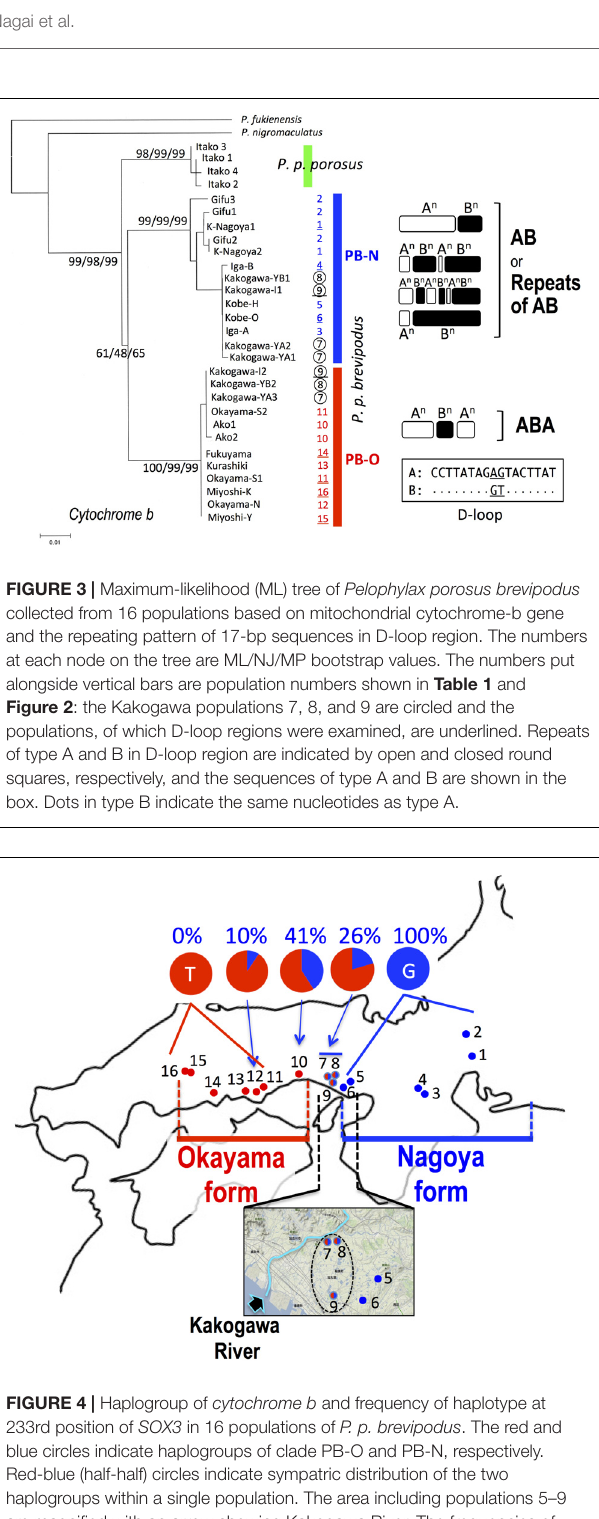
PB-N haplotypes. This indicates that the boundary between the two clades is restricted to the small area of Hyogo